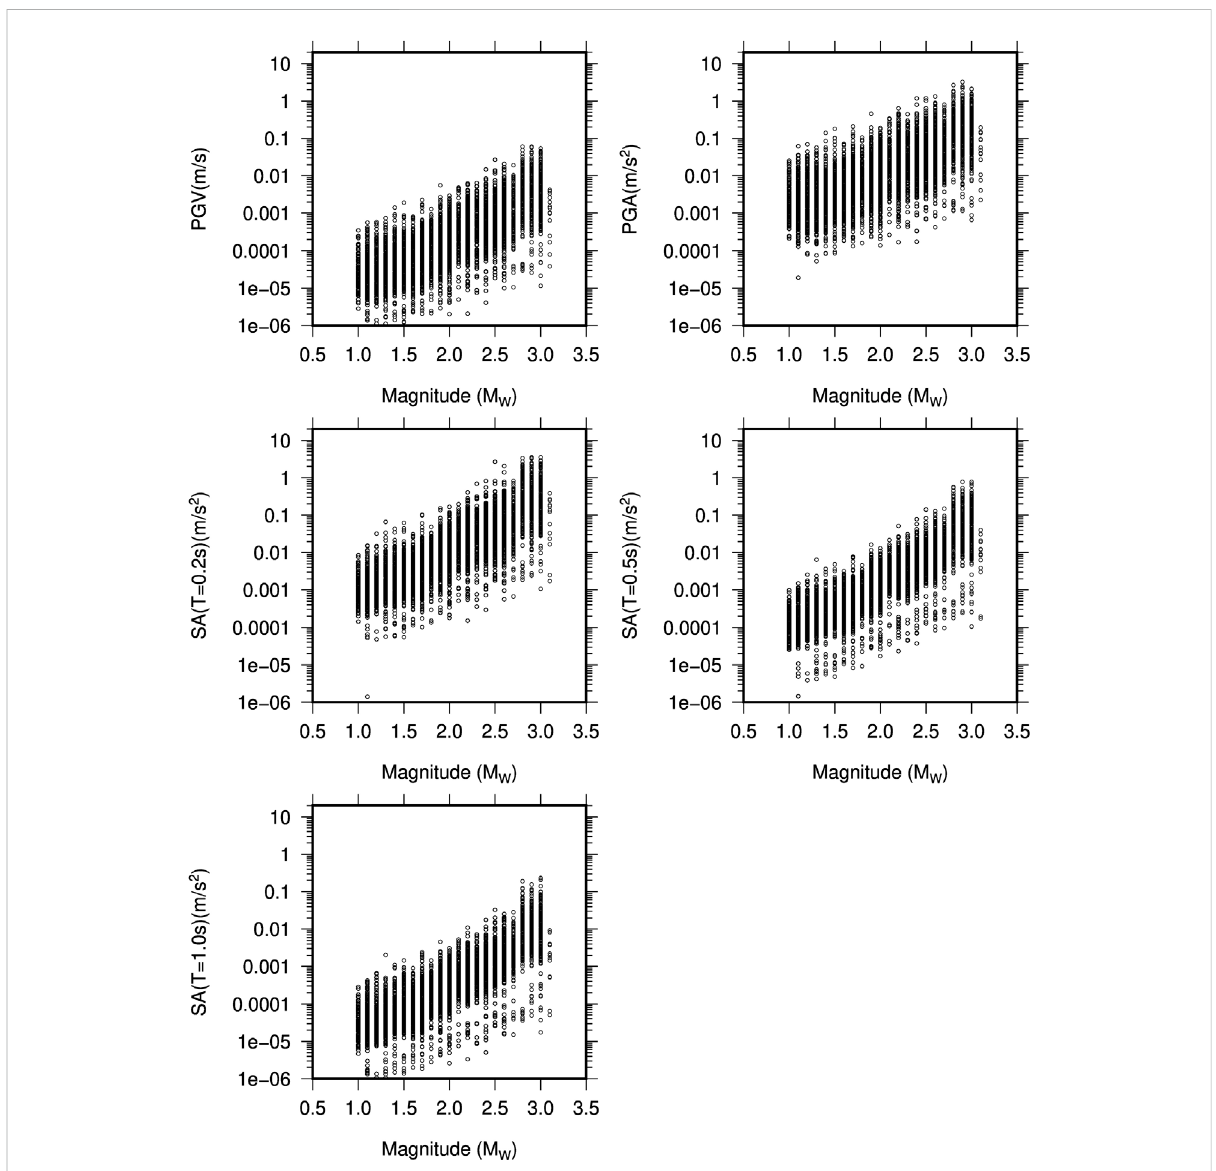
FIGURE 3 Peak ground velocity (PGV), peak ground acceleration (PGA), and spectral acceleration (SA) at 0.2, 0.5, and 1.0 s as function of moment magnitude in the earthquakes selected for the present